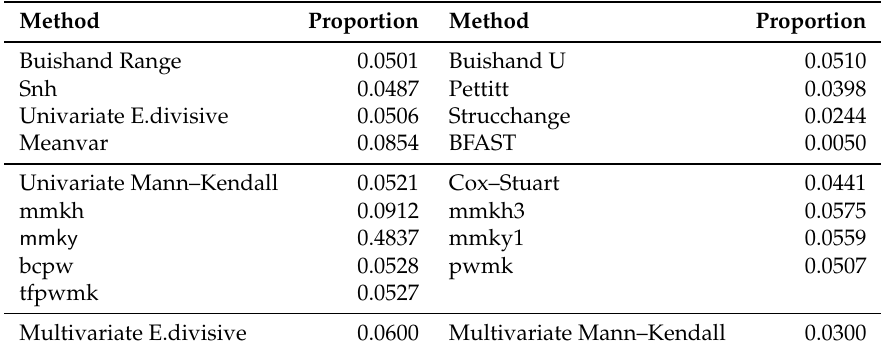
Table 2. Mean type I error probability based on 100 simulations of multi-layer rasters under the first scenario where pixel time series are generated from the standard normal